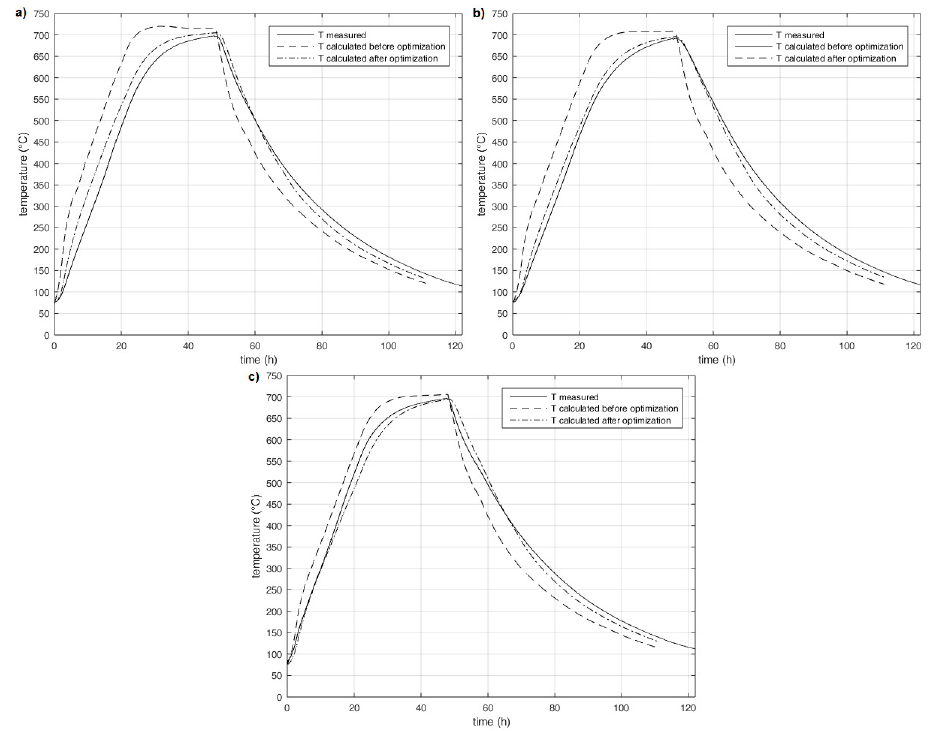
Figure 16. Comparison of directly measured temperature (T measured) to indirectly measured temperature before (T calculated before optimization) and after (T calculated after optimization) optimization for temperature ( a ) T 6 , ( b ) T 7 , and ( c ) T 8 for operating measurement 4, coil